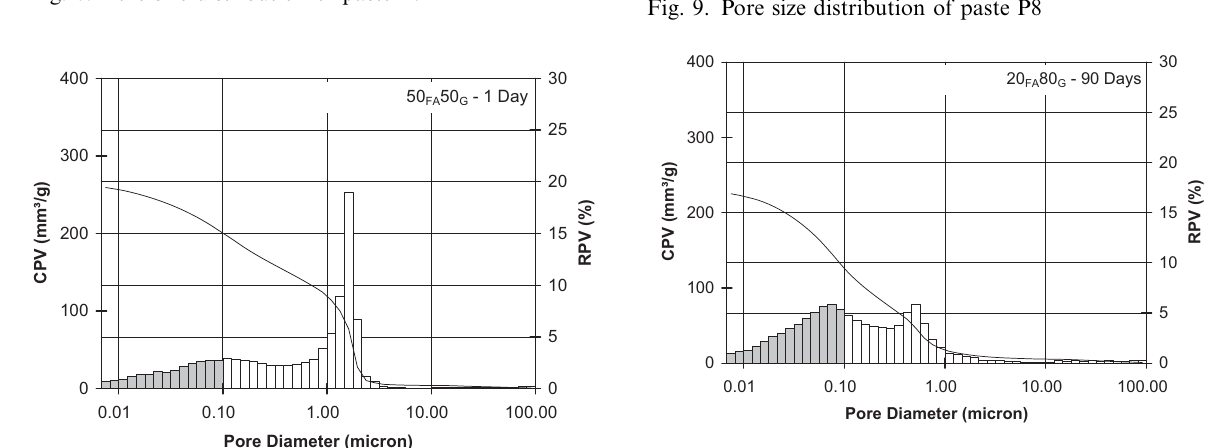
Fig. 10. Pore size distribution of paste P7 at 90 days of curing (Khatib et al. 2012b)